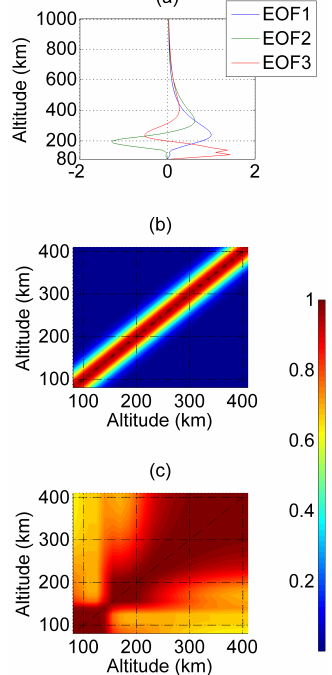
Figure 1. The vertical correlation at long − 122 ◦ and lat 28 ◦ . (a) The EOFs calculated from 62 IRI N e profiles with different sunspot numbers and IG indexes. (b) The location-independent vertical correlation modeled with a Gaussian function. (c) The location- dependent vertical correlation obtained from EOFs and its coeffi-